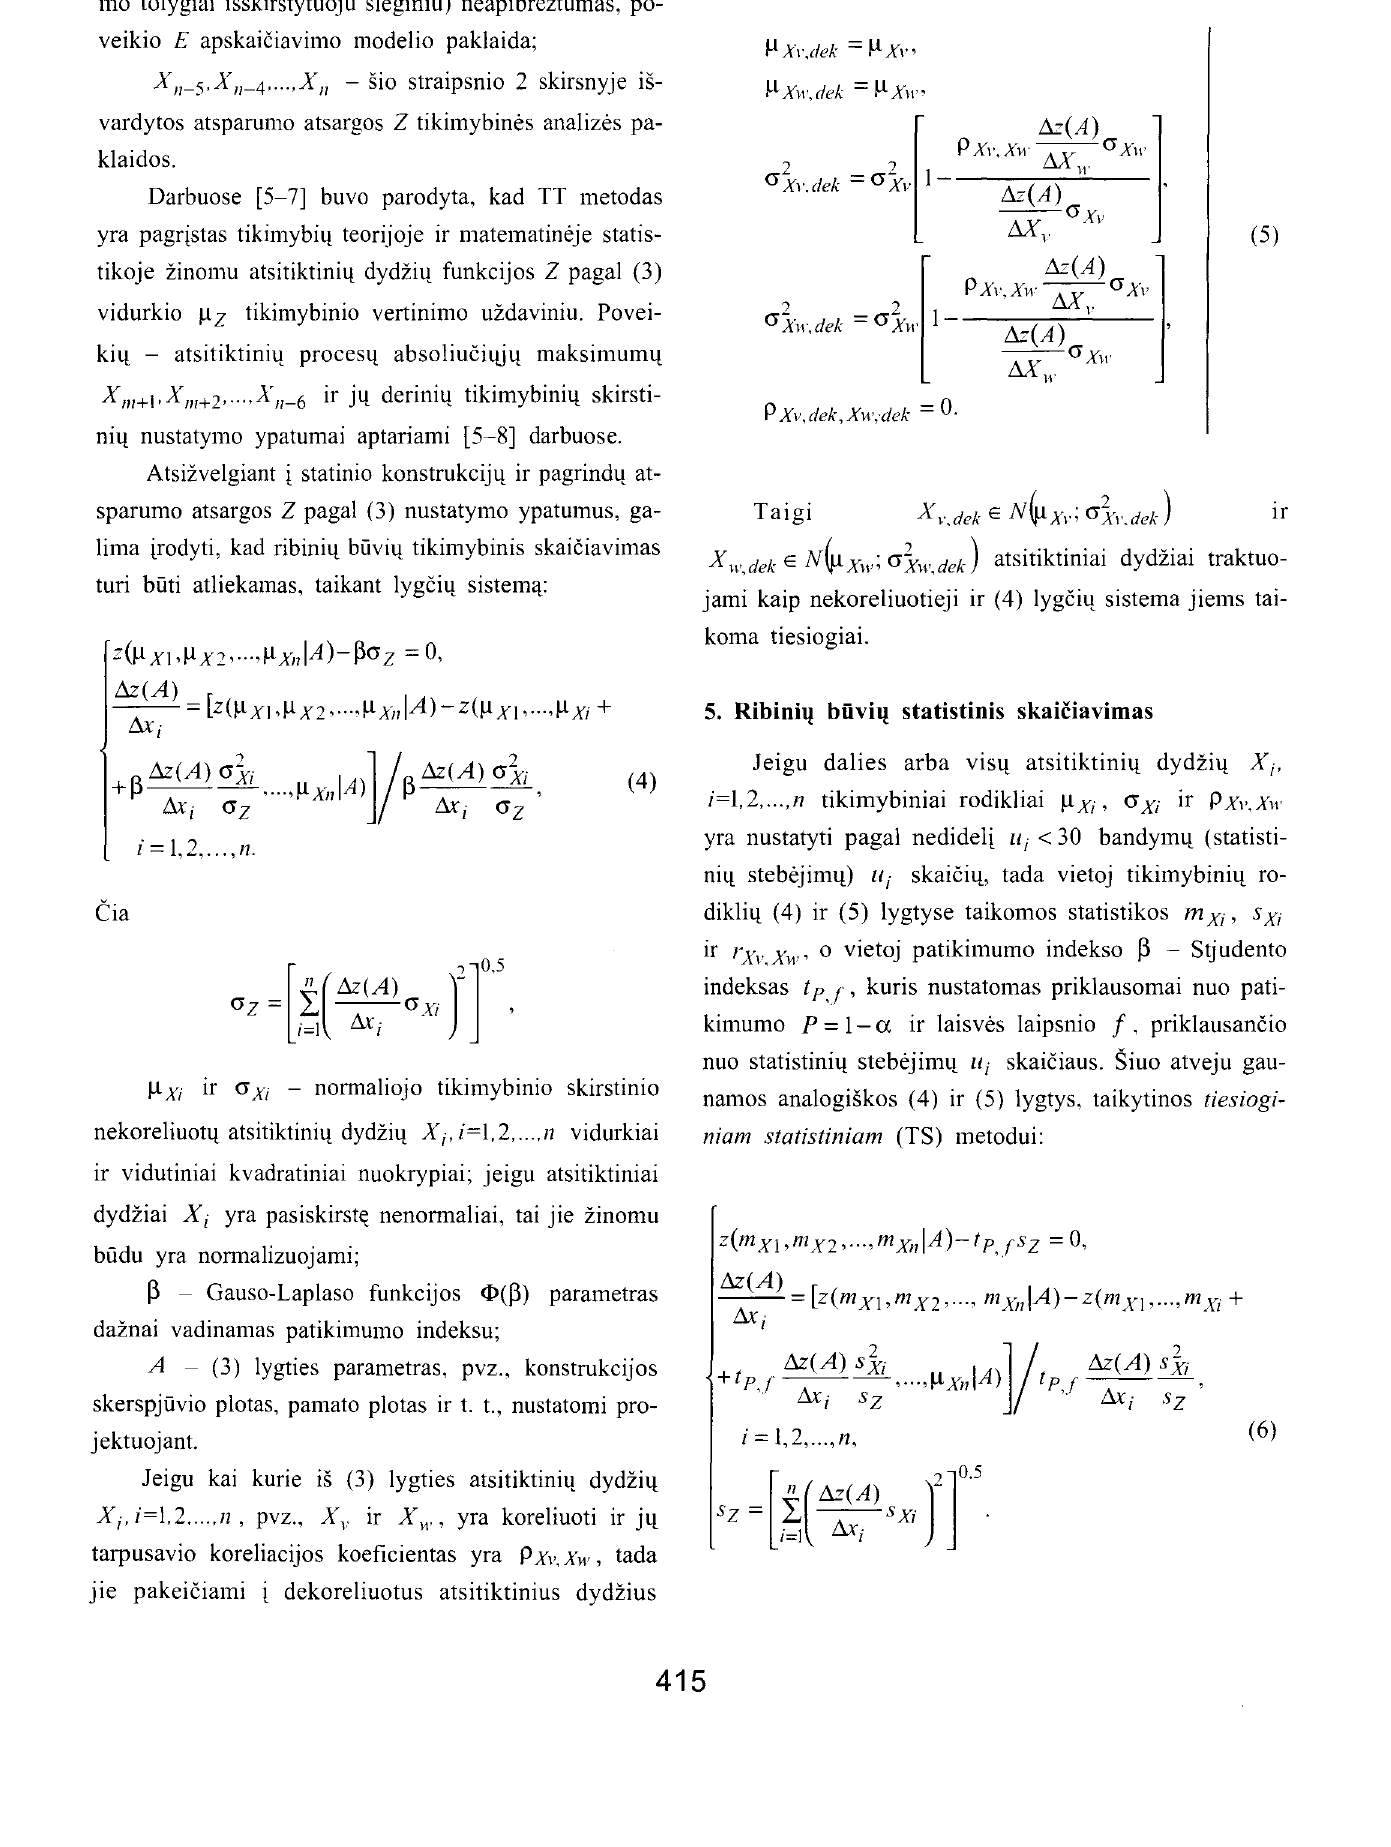
skerspjiivio plotas, pamato plotas ir t. t., nustatomi pro